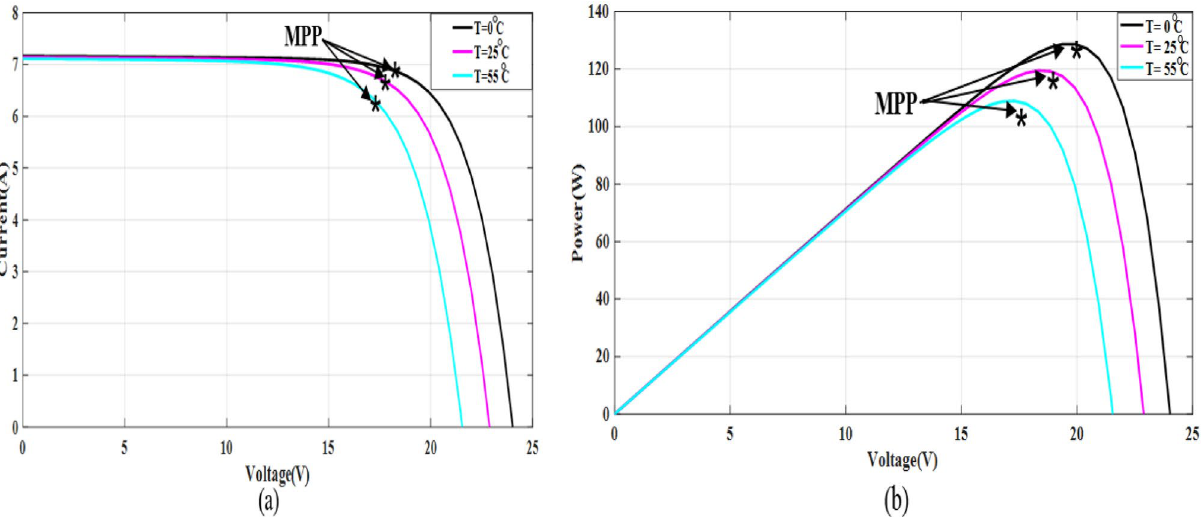
Figure 12. I – V and P – V graphs of double-diode model at different values of temperature and fixed irradiation, G = 1000 W/m 2 ( a ) I – V graph and ( b ) P – V graph.